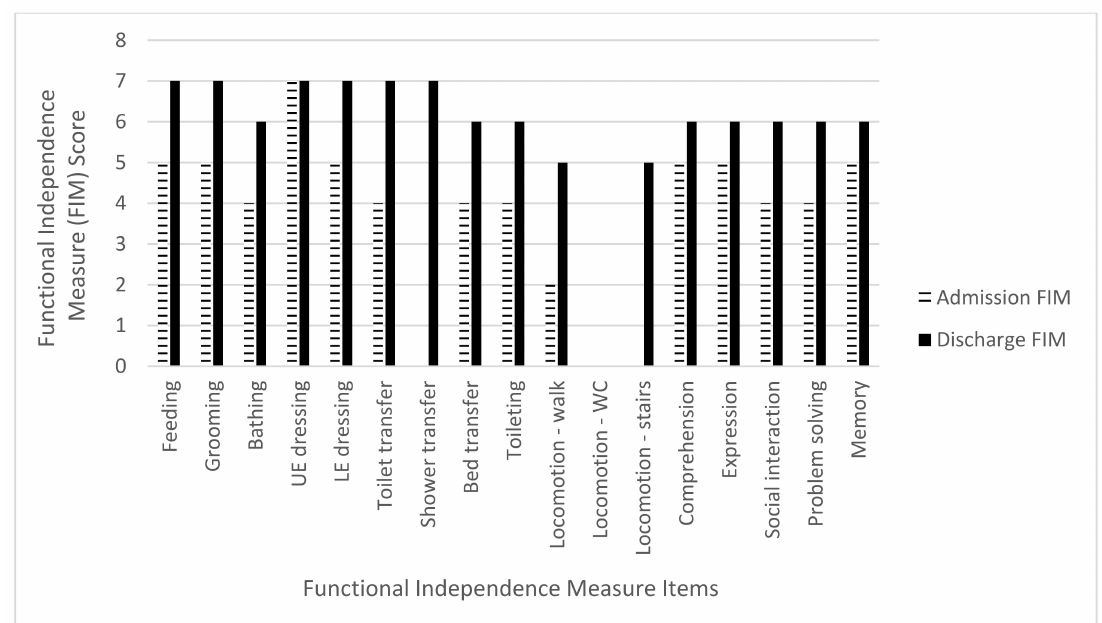
Figure 6. Subject 5 admission and discharge functional independence measure